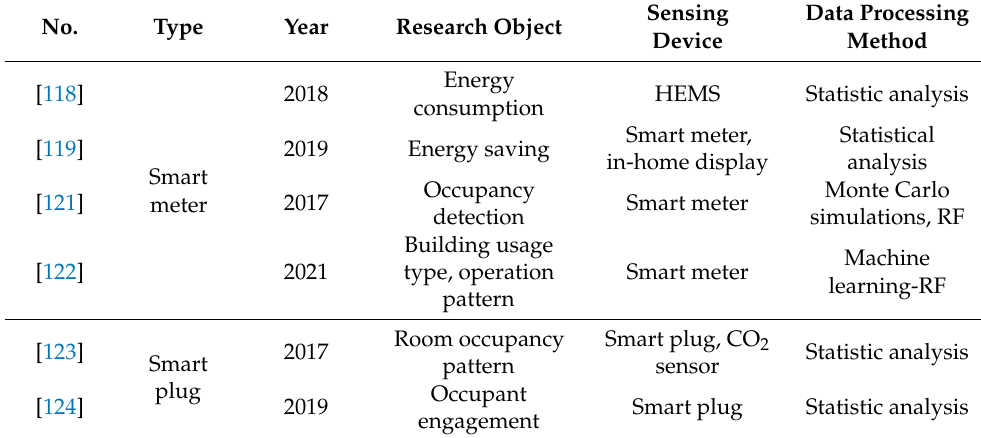
Table 8. The list of references for building consumption sensing.